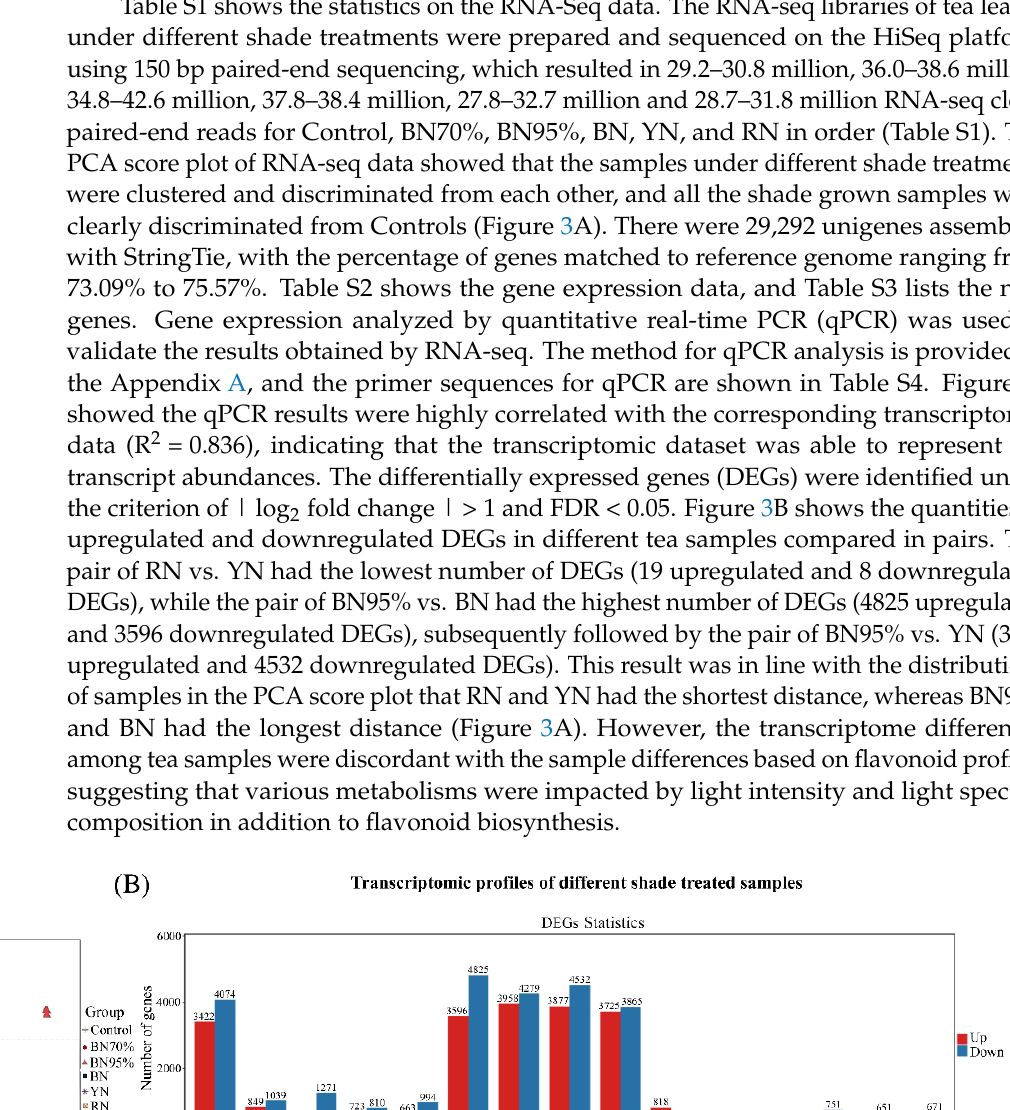
Figure 4A mapped the biosynthetic pathway of flavonoids annotated with the gene expression levels. Chalcone isomerase ( CHI ), flavanone 3-hydroxylase ( F3H ), dihydrofla- vonol 4-reductase ( DFR ), anthocyanidin synthase ( ANS ), and anthocyanidin reductase ( ANR ) are the key structural genes regulating the biosynthesis of catechins, and flavonol synthase ( FLS ) and UDP glucose-flavonoid-3- O -glycosyltransferases ( UFGT ) are commit- ted to the biosynthesis of flavonol glycosides. For phenylpropanoid biosynthesis pathway circled in a blue solid line (Figure 4A), only phenylalanine ammonia-lyase ( PAL ) was gen- erally downregulated upon shading. For flavonoid biosynthesis pathway circled in a pur- ple dotted line, with a decline in the light intensity under black net shade treatment, the expressions of chalcone synthase ( CHS ), F3H and flavonoid 3 ′ -hydroxylase ( F3 ′ H ) were downregulated gradually, which were opposite to the change trends of DFR , ANR , LAR,